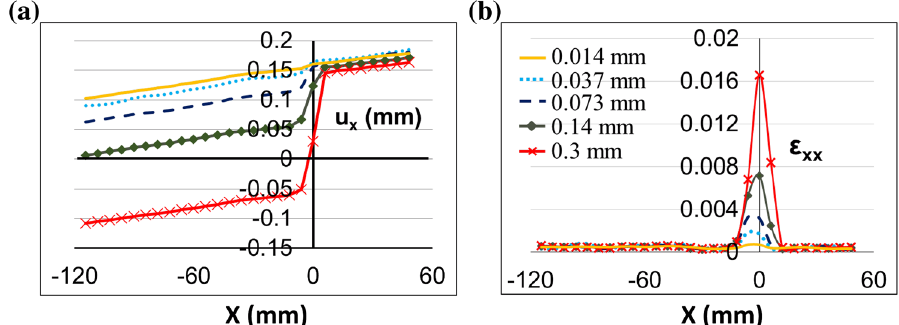
Fig. 5 Variation of U x and e xx with varying X located at Y = 37 mm in SFRC specimen with V f = 0.5% (load response shown in Fig. 3): a U x with X; b e xx with X for different values of CMOD.